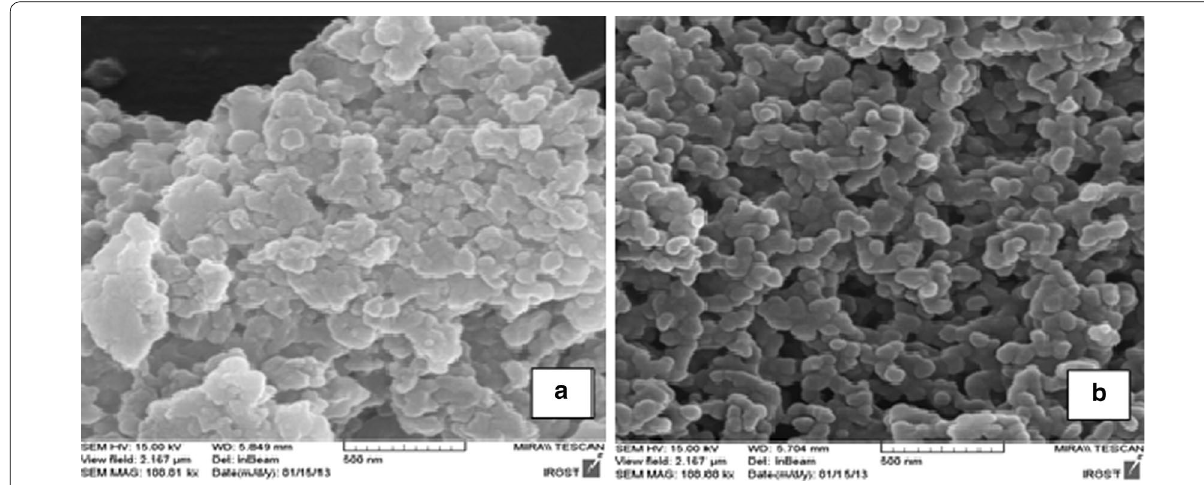
Fig. 1 SEM images of adsorbents prepared for adsorption of Pb. SEMs were recorded in the acceleration voltage 15.00 kV and magnitude for focusing on surface porous. a SEM image of pomegranate peel carbon and b iron modified pomegranate peel carbon. There was a significant difference of porous between two image corresponding